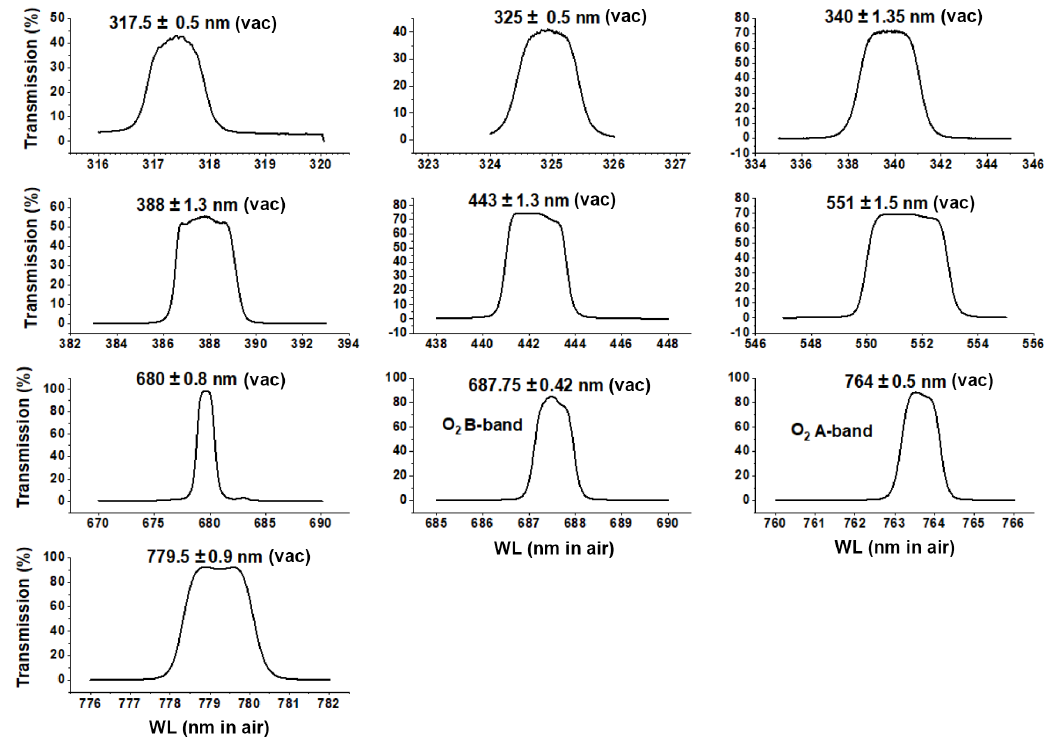
Figure 1. Filter transmission functions (percent) for the 10 EPIC wavelengths. Center wavelengths are in vacuum